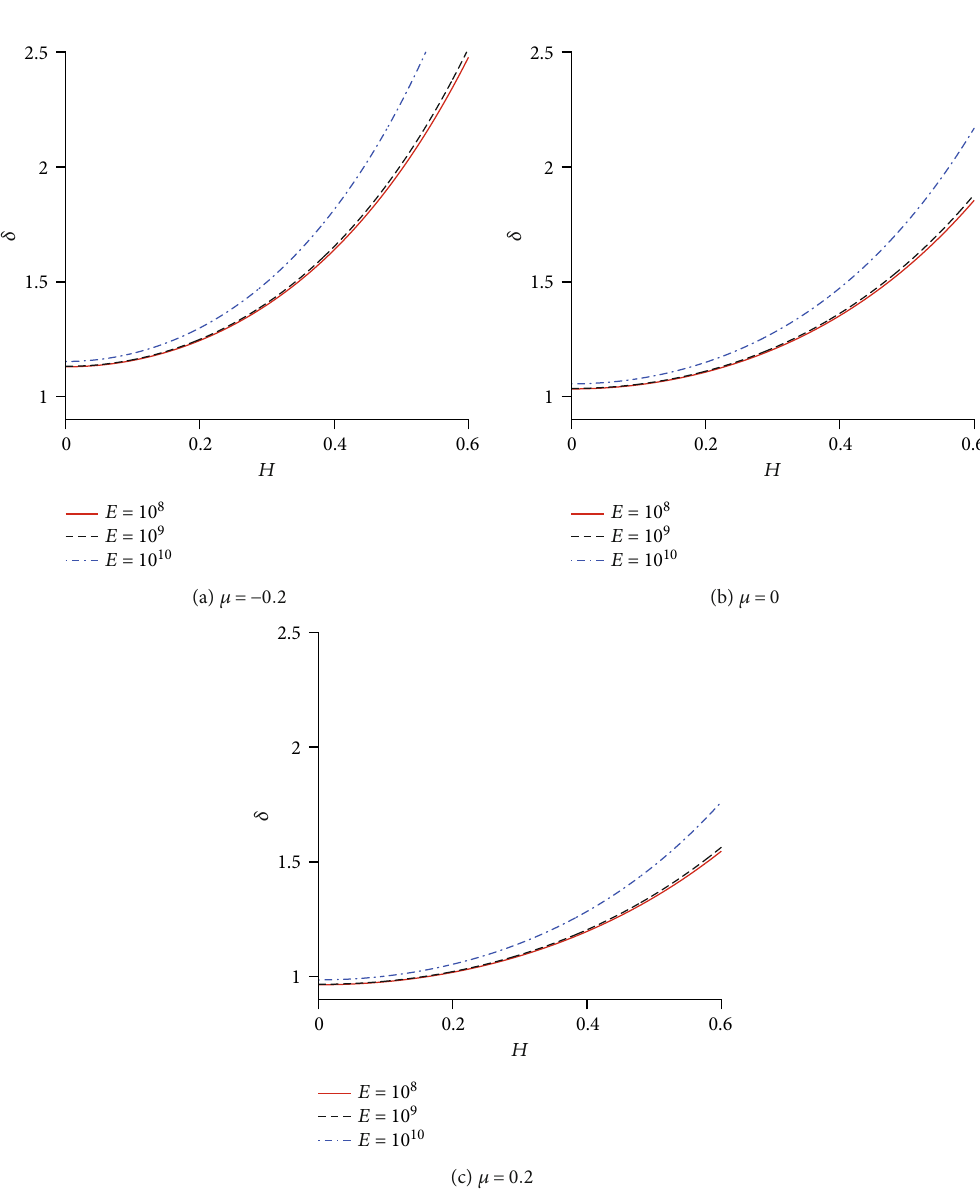
Figure 6: The in fl uence of Young ’ s modulus E on the phase velocity δ ð = c 2 / c 2